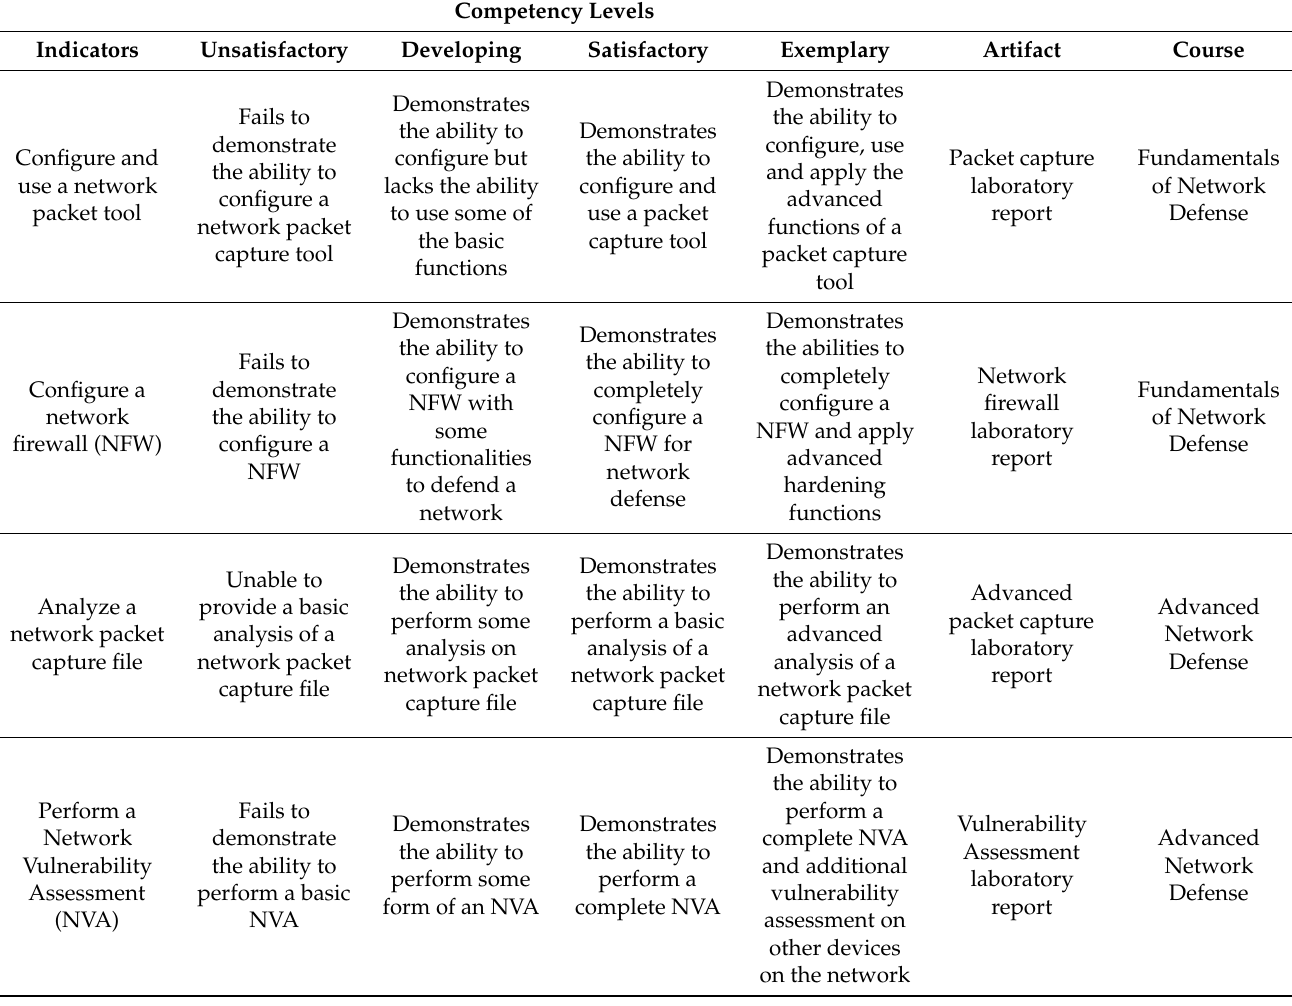
Table 5. Competency Assessment Tool for Computer Network